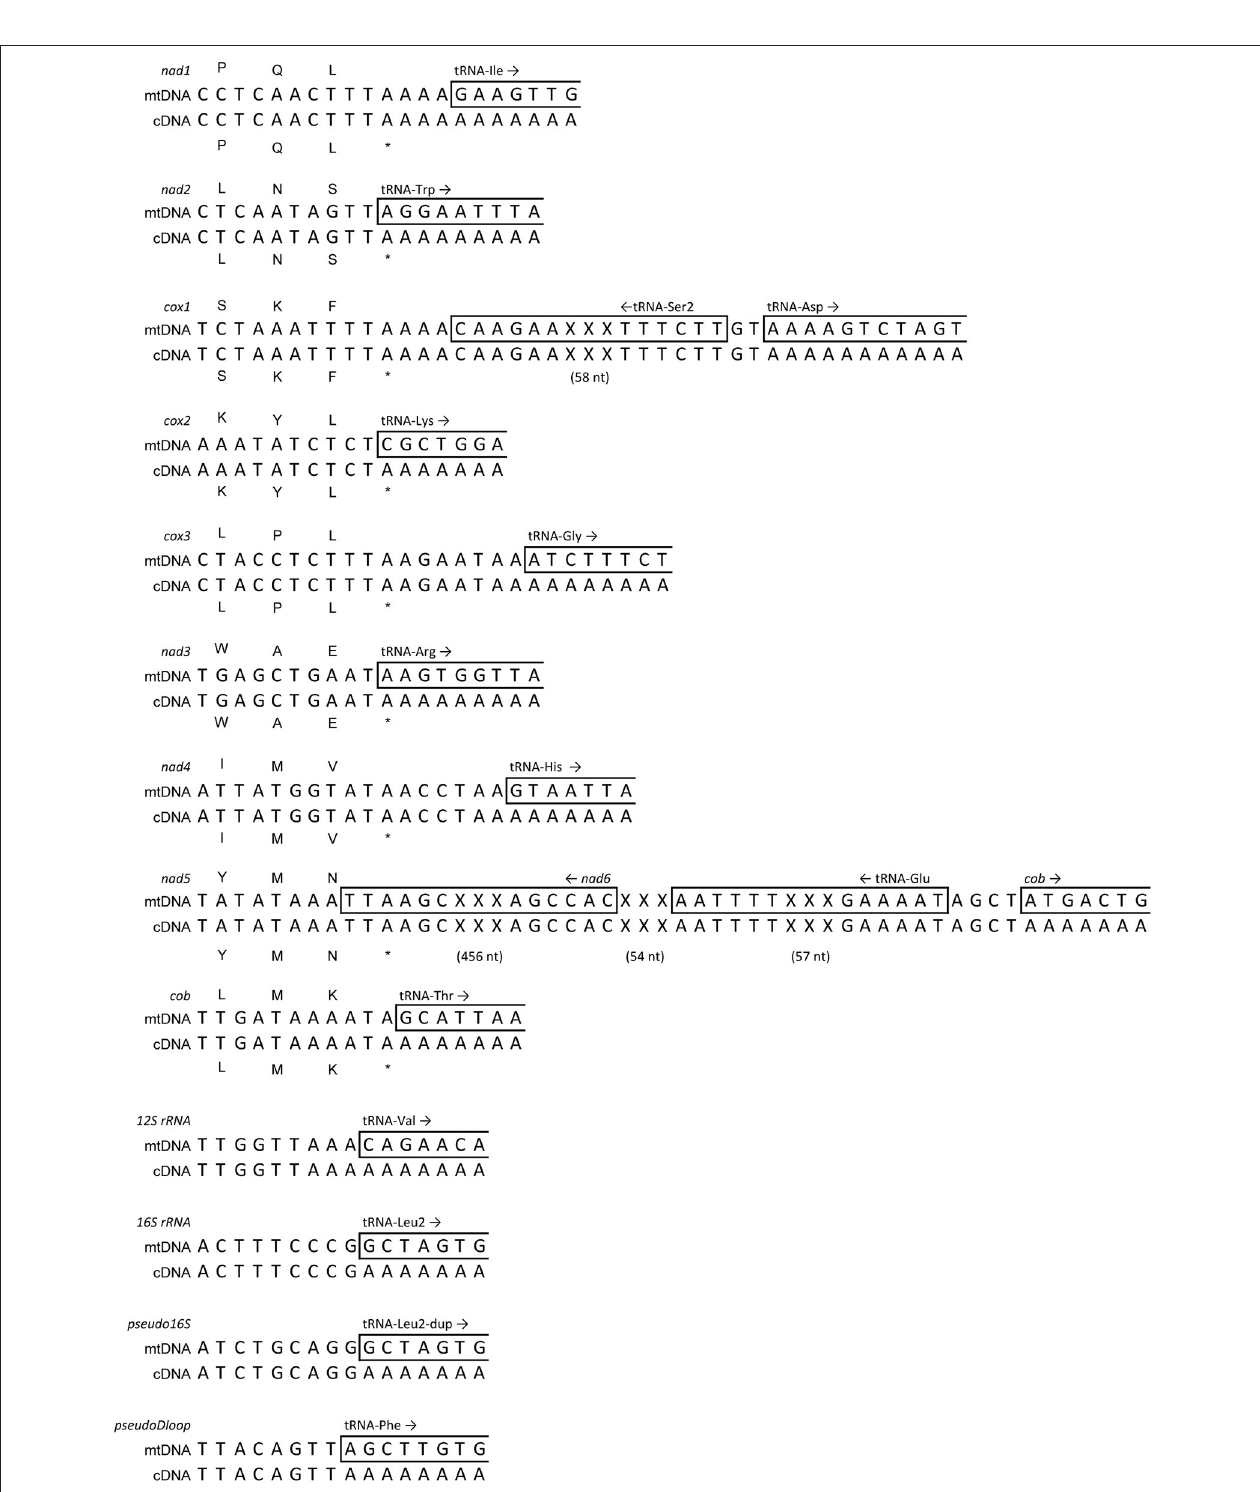
FIGURE 10 | Predicted polyadenylation sites based on RNAseq mapping onto mitochondrial transcripts. RNAseq reads were mapped to the A. limnaeus mtgenome using Geneious in order to predict polyadenylation sites at the 3 ′ ends of several coding and non-coding regions. For clarity, some nucleotides in COXI and ND5 have been omitted, replaced with “XXX,” and are noted with the number of nucleotides in parenthesis.